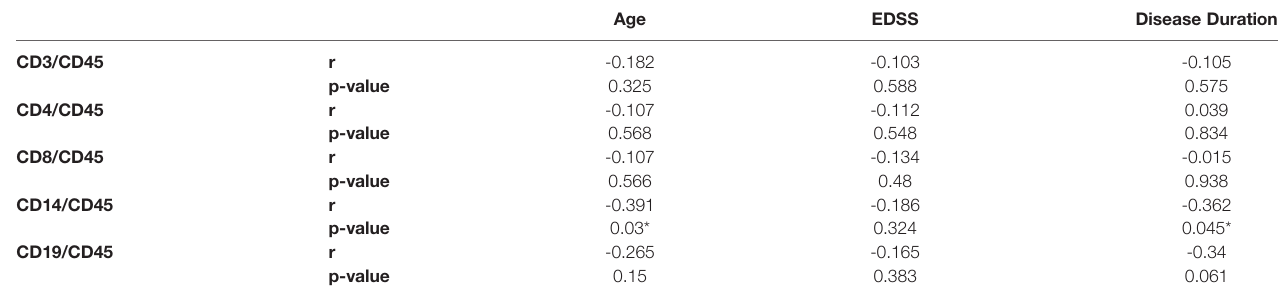
TABLE 2 | Spearman correlation coef fi cients of lymphocyte EV populations with clinical and demographic variables in MS patients. Age Disease Duration